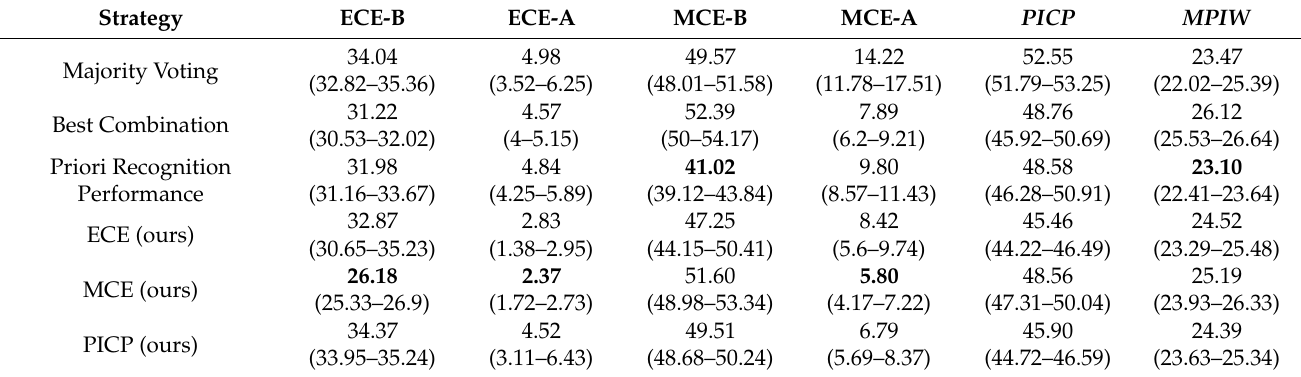
Table 6. Calibration output of the ensembled models on the test